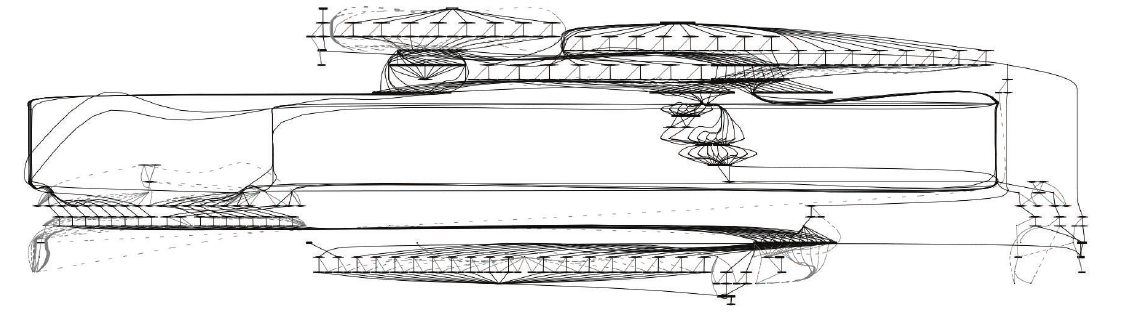
Figure 8: The FlowVR flat network of the Grimage application. Nodes are modules and edges communication channels. This network is compiled for 8 cameras and EPVH parallelized on 6 CPUs.